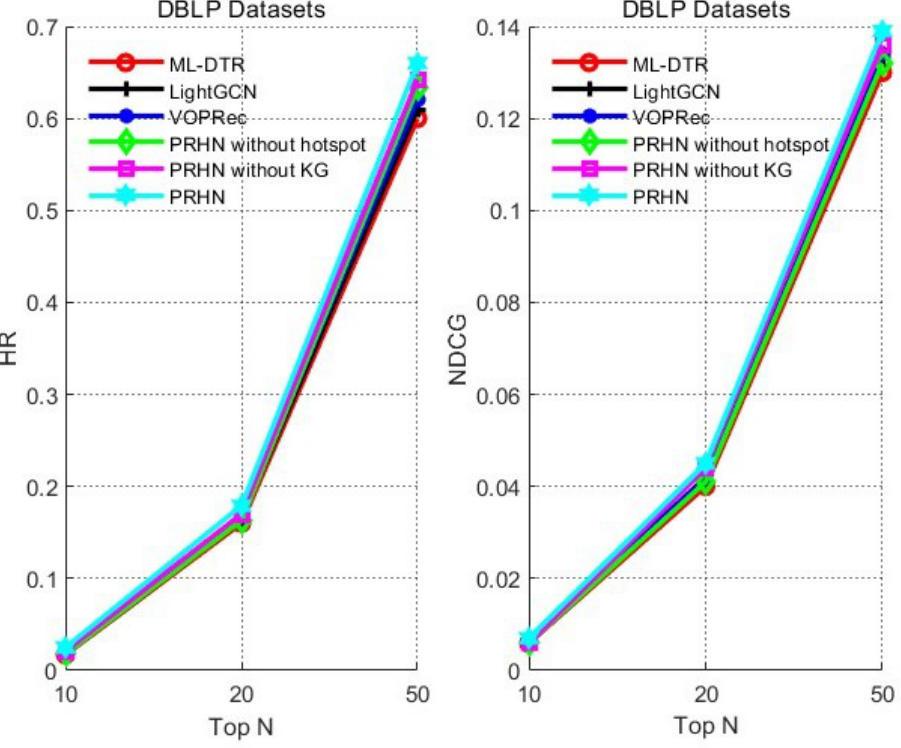
Figure 4. Performance of different models on DBLP